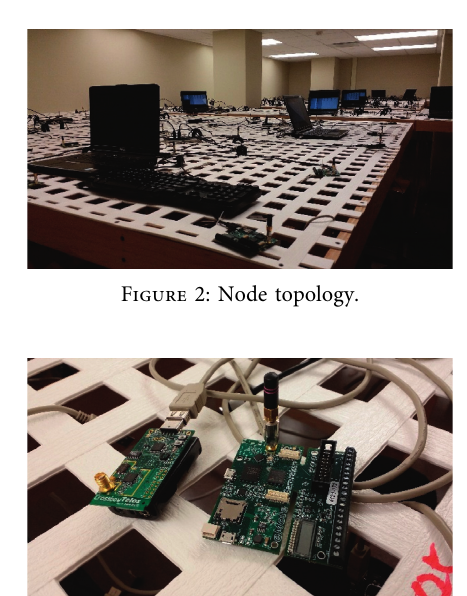
Figure 1: System architecture.